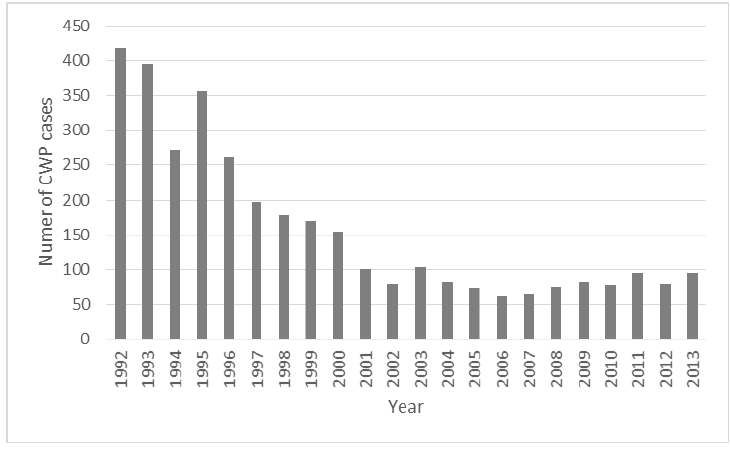
Figure 1. The number of newly reported cases of CWP in individual years.